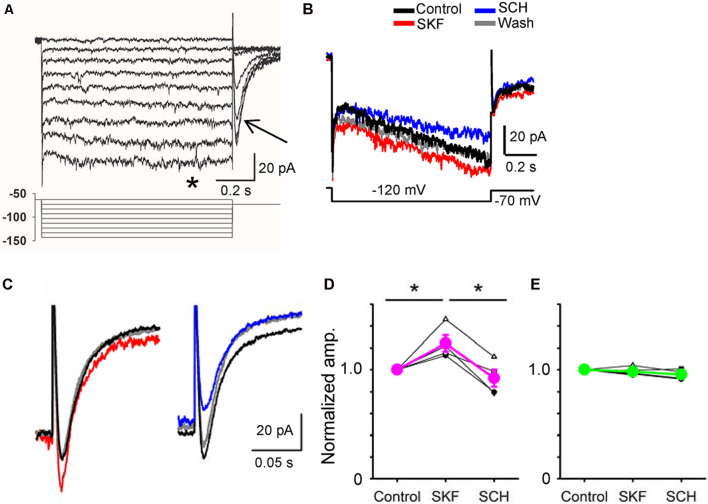
A D1R agonist and an antagonist modulated hyperpolarization-activated cyclic nucleotide-gated (HCN) currents in a bipolar cell. (A) Voltage steps (lower panel) evoked inward currents in a type 5-2 bipolar cell. Steady-state currents (*) and tail currents (arrow). (B) HCN currents were evoked in a type 5-2 bipolar cell. SKF increased the HCN steady-state current, whereas SCH decreased the current. (C) The tail current was also increased by SKF38393 (red). SCH23390 decreased the tail current (blue) in the same cell. (D) A summary graph shows that SKF increased the HCN tail current in four bipolar cells (p < 0.05), and SCH decreased the current (p < 0.01, *p < 0.05.). (E) In five bipolar cells, SKF and SCH did not change the HCN tail current (p > 0.1).